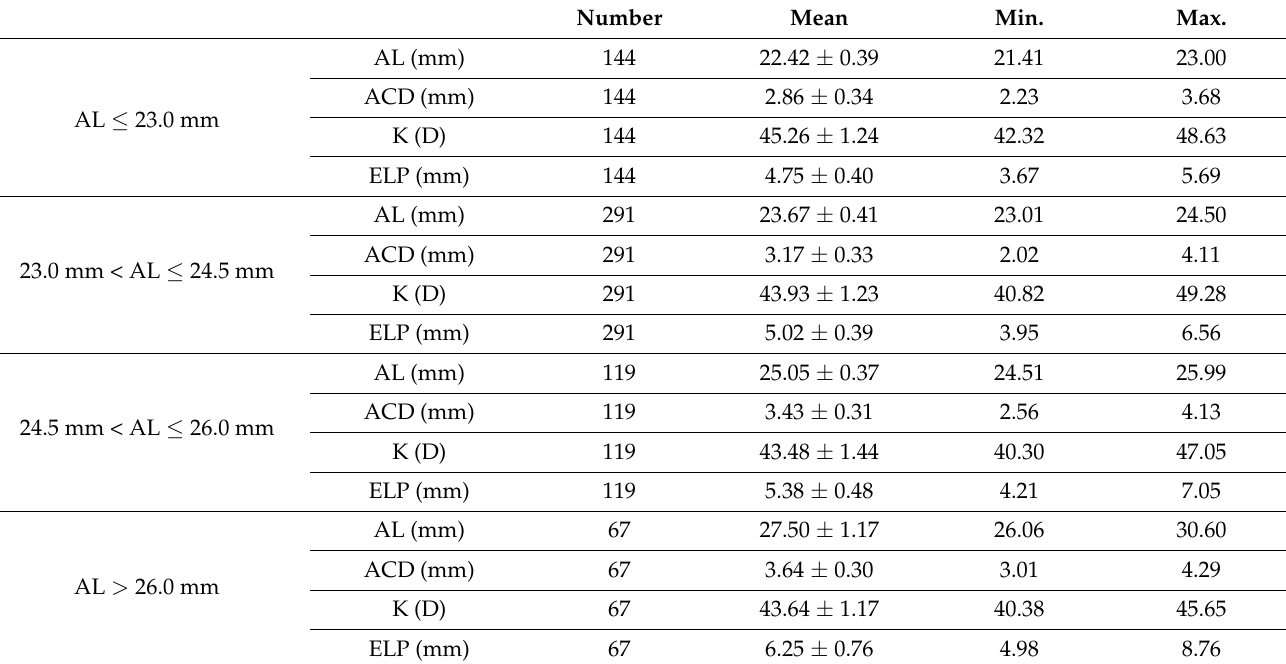
Table 3. Demographic data in 4 subgroups classified according to preoperative axial length (AL). Number Mean Min. Max. Min. Max.